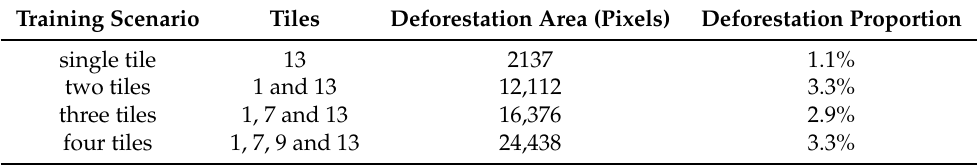
Table 1. Deforestation area and tiles present in the distinct training scenarios.